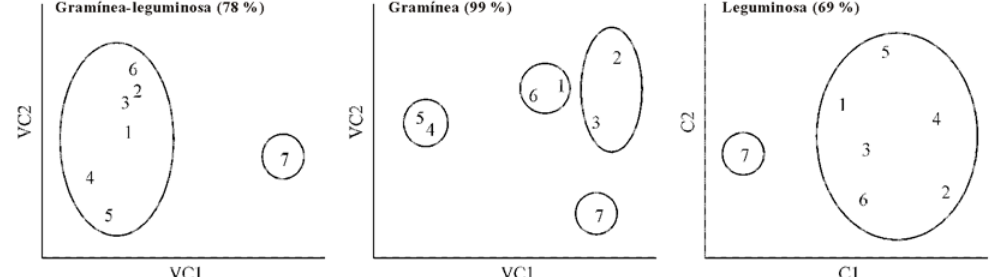
Figura 3. Dispersão dos sete porta-enxertos em relação às duas variáveis canônicas (VC1 e VC2) e aos dois primeiros componentes principais (C1 e C2), agrupados pelo método de Tocher (círculos e elipses), para as variáveis produção, número de frutos, desenvolvimento vegetativo e teores de nutrientes foliares das laranjeiras ‘Folha Murcha’, em sistemas de manejo da cobertura do solo com gramínea-leguminosa, gramínea e leguminosa. Porta-enxertos: 1 - (limoeiro ‘Cravo’), 2 - (limoeiro ‘Rugoso da África’), 3 - (limoeiro ‘Volcameriano’), 4 - (tangerineira ‘Cleópatra’), 5 - (tangerineira ‘Sunki’), 6 - (citrangeiro ‘C-13’) e 7 - (trifoliata). Os percentuais dentro dos parênteses correspondem aos valores dos dois primeiros